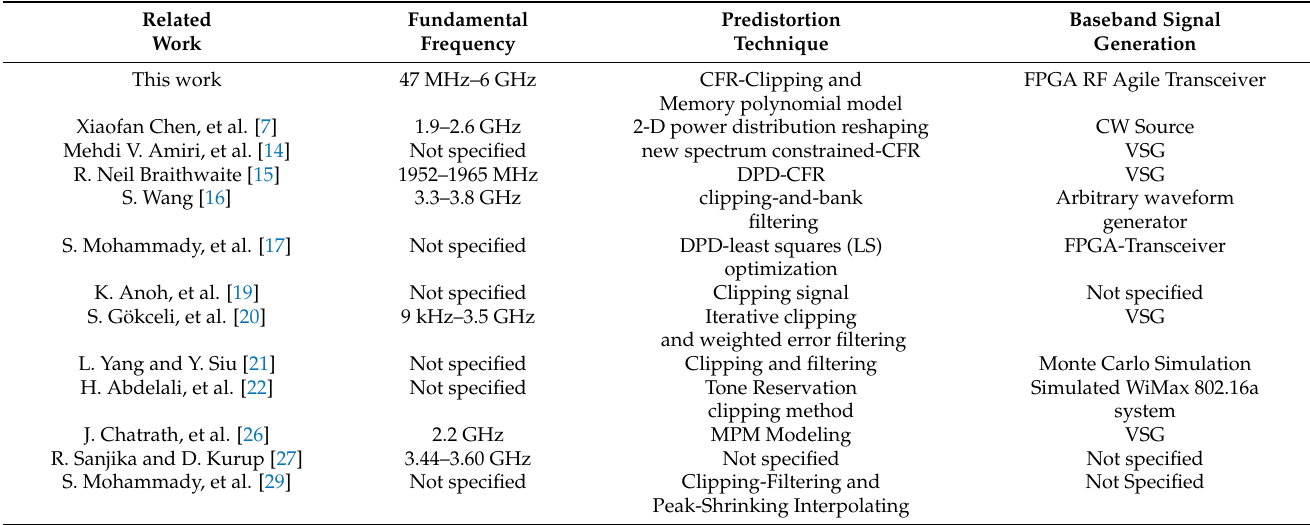
Table 4. Comparative table for the CFR technique, linearization method and signal generation.